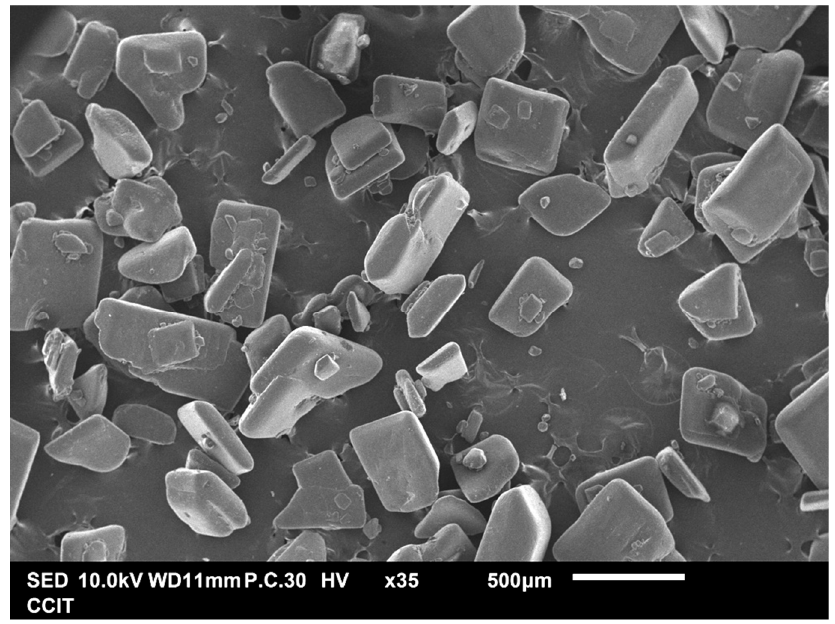
Figure 1. SEM image of raw p-TSA.